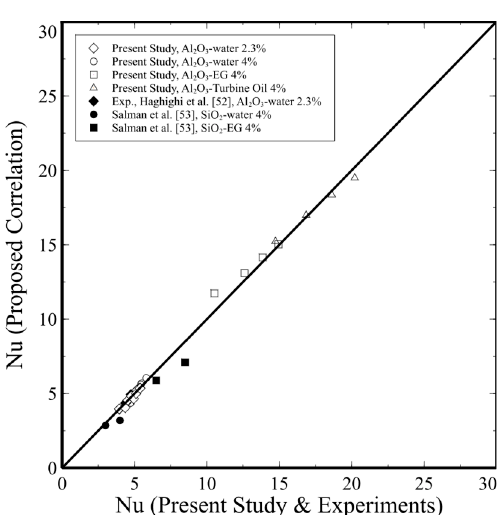
Figure 15. Proposed correlation vs computed results and experiments of Nu in a straight tube.